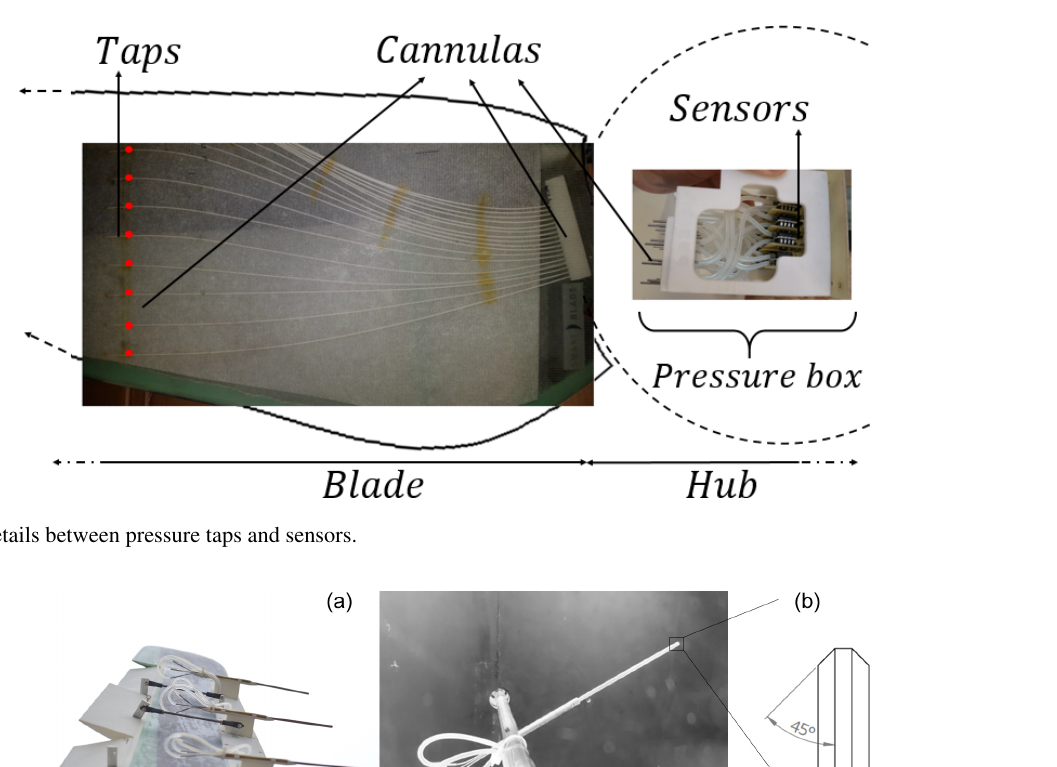
Figure 6. Three-hole probes mounted in the equipped blade (a) . Calibration of a three-hole probe and tip details (b) . It is noted that although the flaps appear deflected in the photo, they were always in the neutral position for the experiments of this campaign.